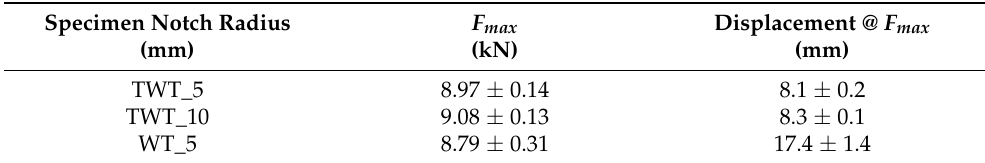
Table 4. Maximum load and corresponding displacement of Type A, 110 SDR 9 TWT, and WT specimens.